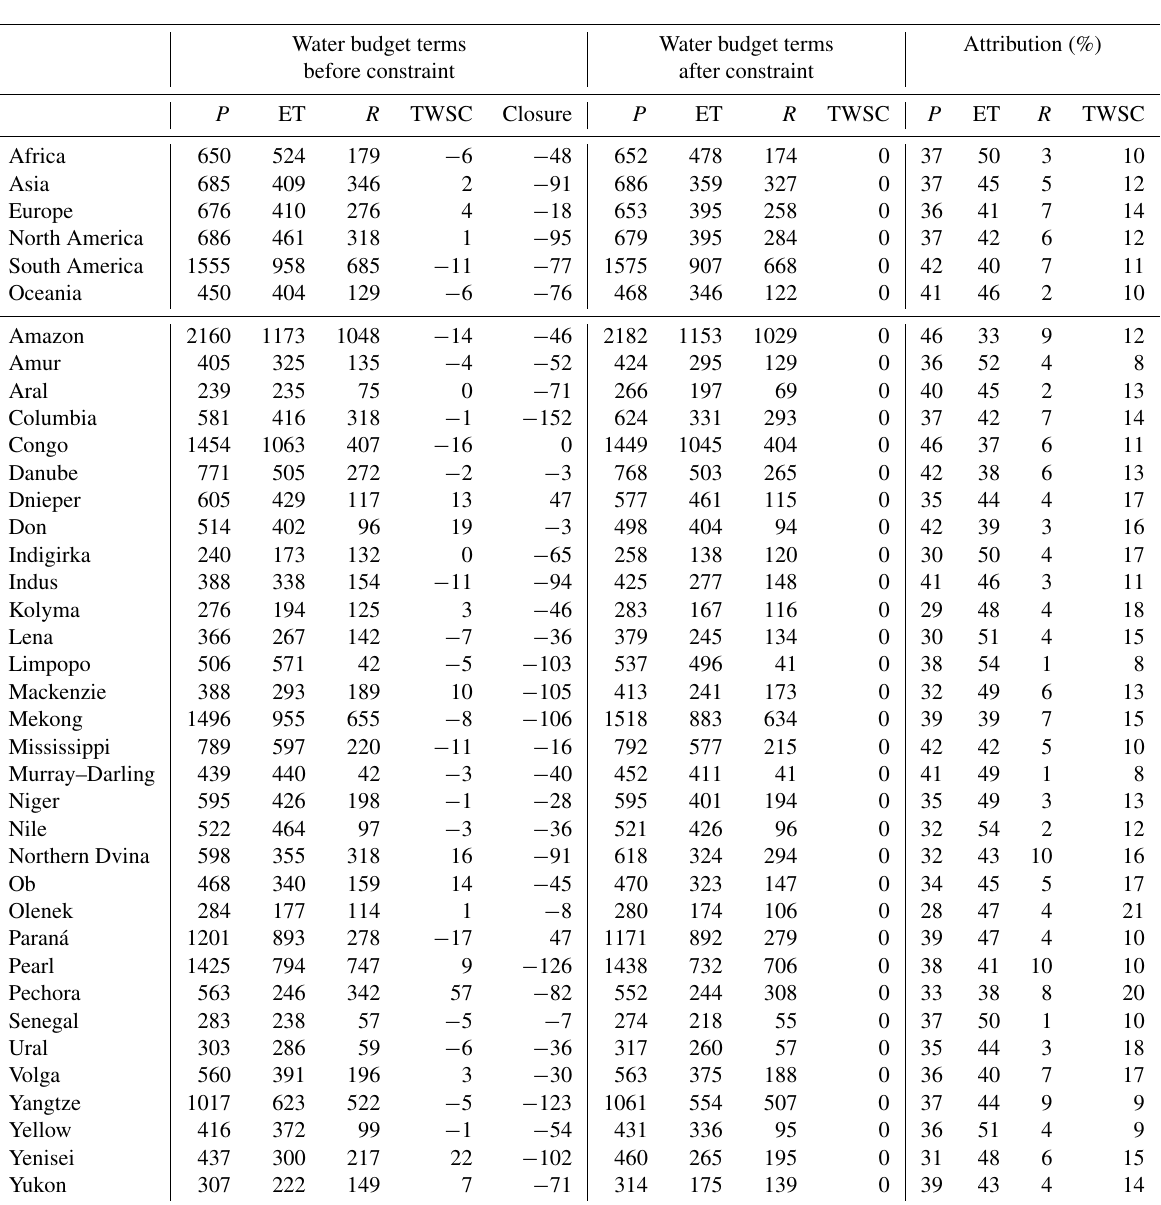
Table 4. The summary table of annual mean water budgets (mmyear − 1 ) before and after water balance constraint and their corresponding attributions (%) to the non-closure error at both continental and basin scales (Greenland is excluded for North